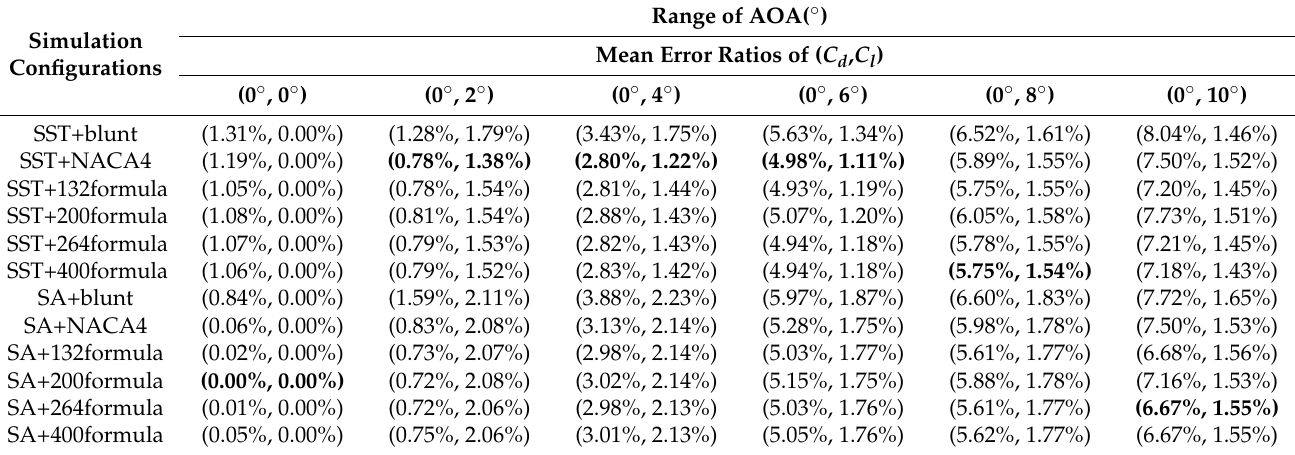
Table 16. The mean error ratios of C d and C l of 20 m far-field